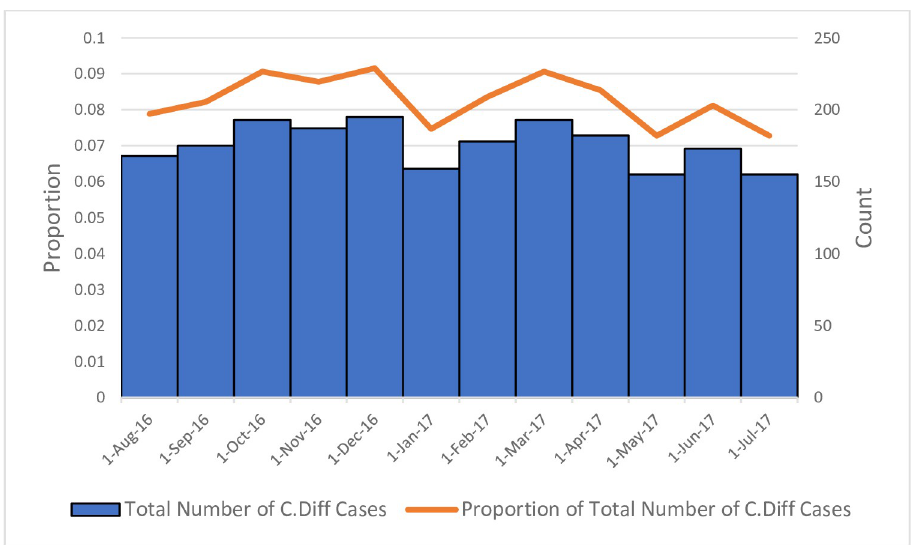
Fig 2. Seasonal variation in number of CDI cases diagnosed in the South African public healthcare sector 2016/ 2017. Epidemiological curve for CDI cases between July 2016 and June 2017. CDI cases varied during the year with the greatest number of cases diagnosed during the month of December (n = 195) and the lowest during May and July (n =